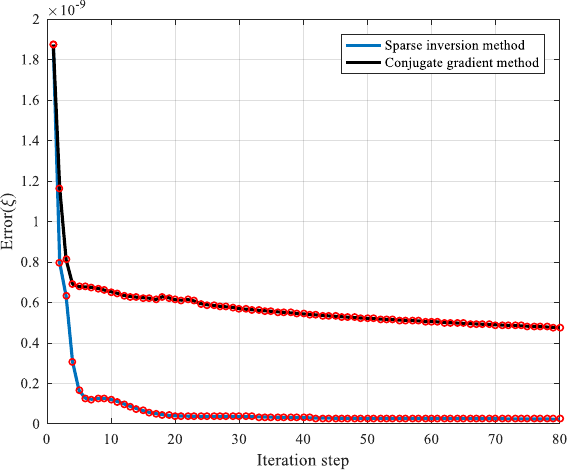
Figure 15. Inversion algorithm calculation process.